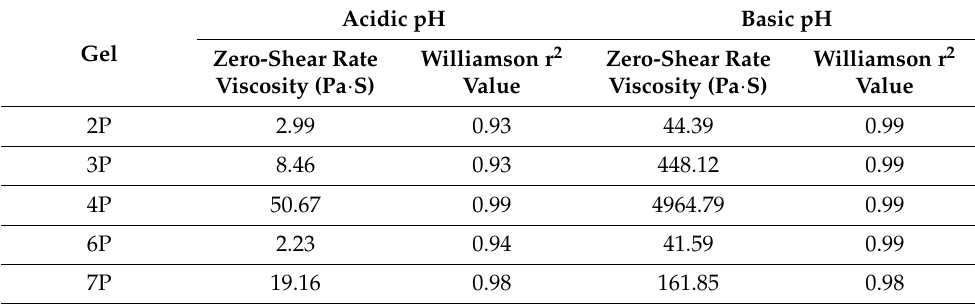
Table 3. C i -PVA-BA gels showed pH-dependent changes in the zero-shear rate viscosity. Acidic Gel